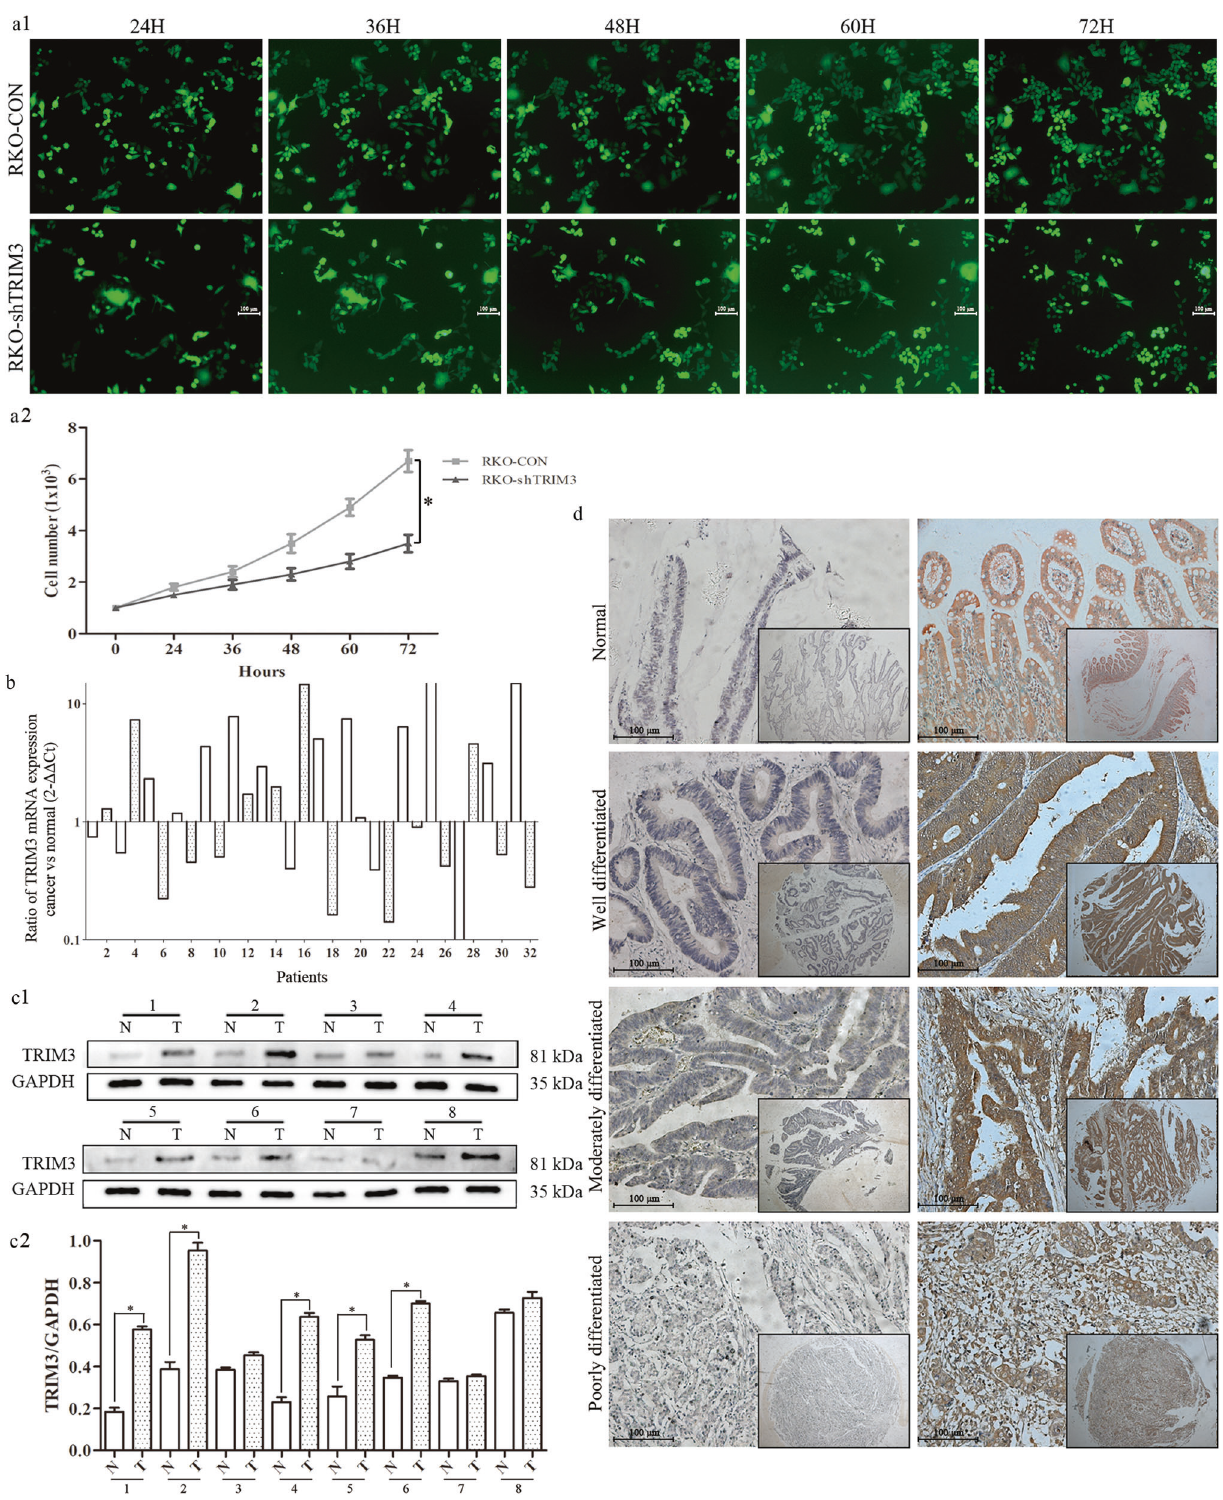
Fig. 1 RKO cells with TRIM3 knockdown monitored by HCS technology and TRIM3 expression in CRC tissues. a1 Dynamic growth of GFP- labeled RKO cells transfected with control and TRIM3-shRNA was monitored twice a day for 3 consecutive days by HCS. (Magni fi cation ×50); a2 The growth curves of RKO cells transfected with control and TRIM3-shRNA at different time points; b TRIM3 mRNA expressions in 32 pairs of CRC samples. white histogram: odd samples; gray histogram: even samples; c1 TRIM3 protein expression in representative eight pairs of CRC samples (T) and adjacent non-cancerous mucosa (N) by Western Blot; c2 The quanti fi cation expression of TRIM3 in eight pairs of CRC samples; d Immunohistochemical staining of TRIM3 in CRC tissue microarray. Original magni fi cation ×50 and ×200 for inset images.